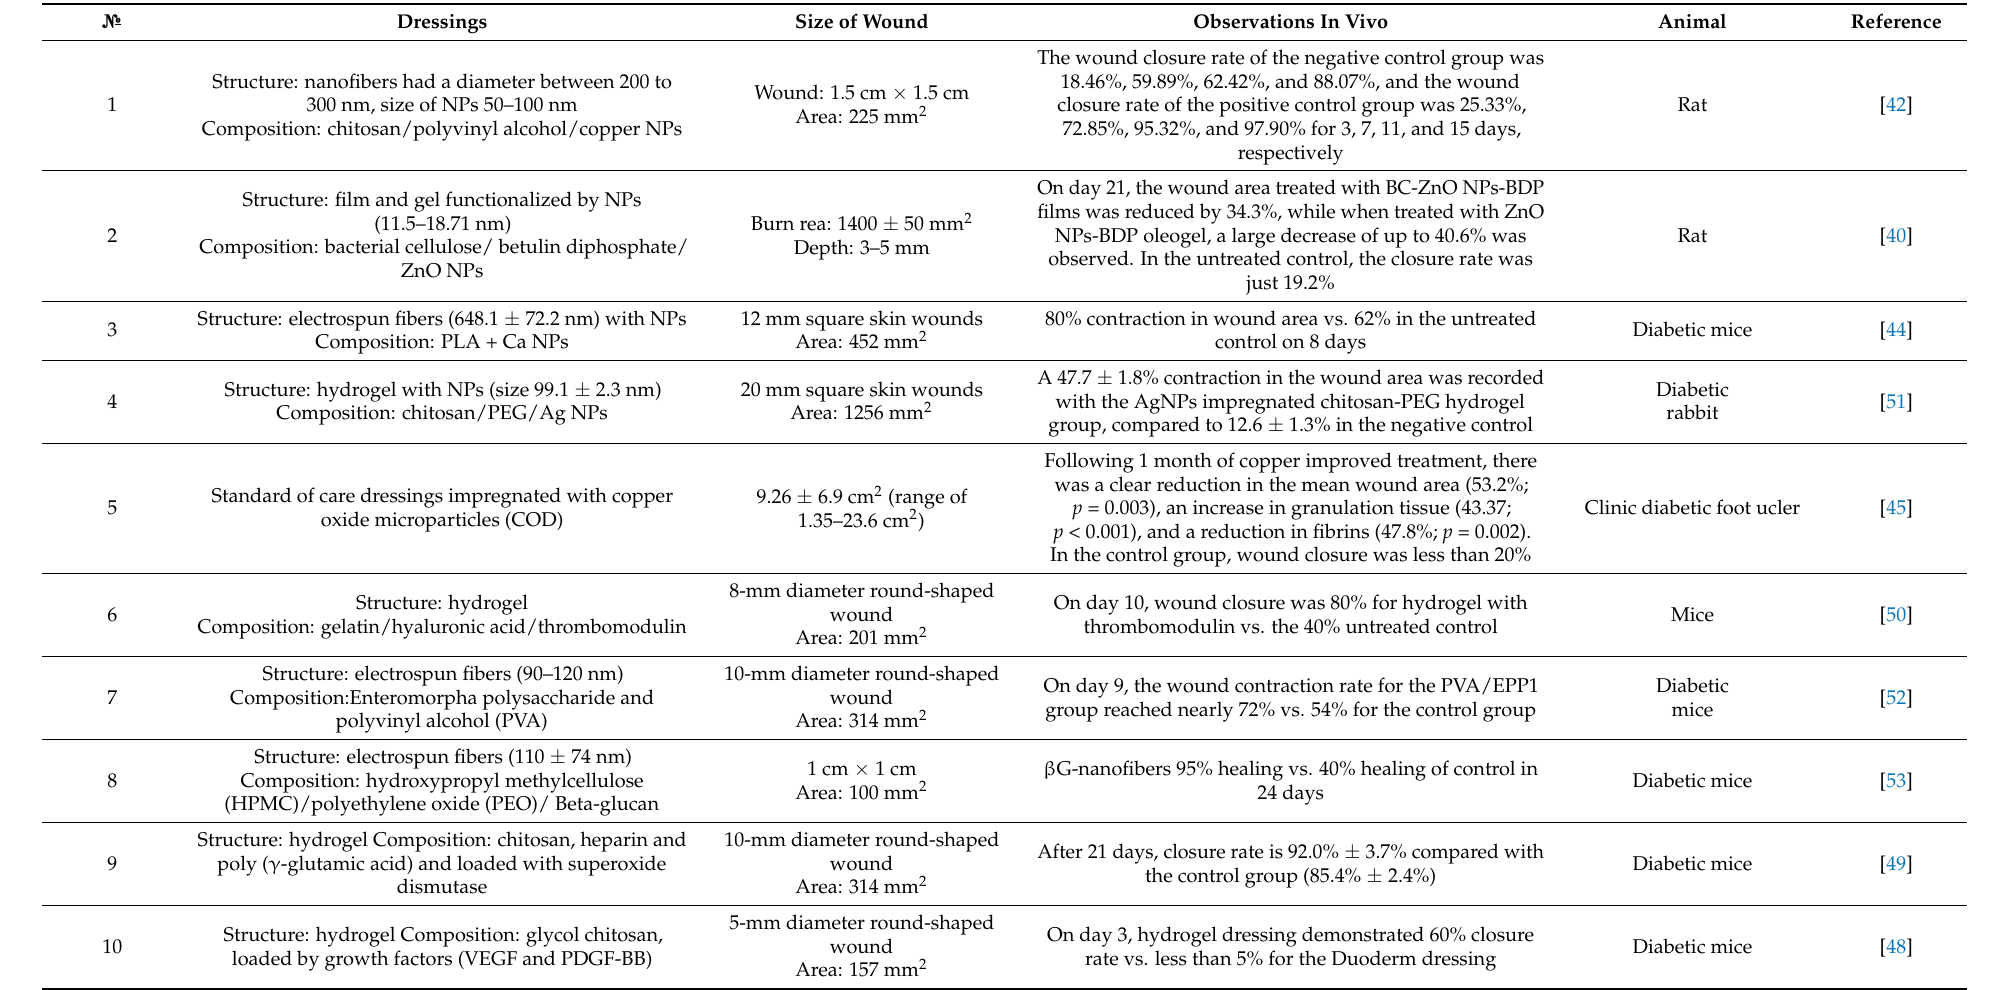
Table 3. Recent studies of the developed dressings for wound